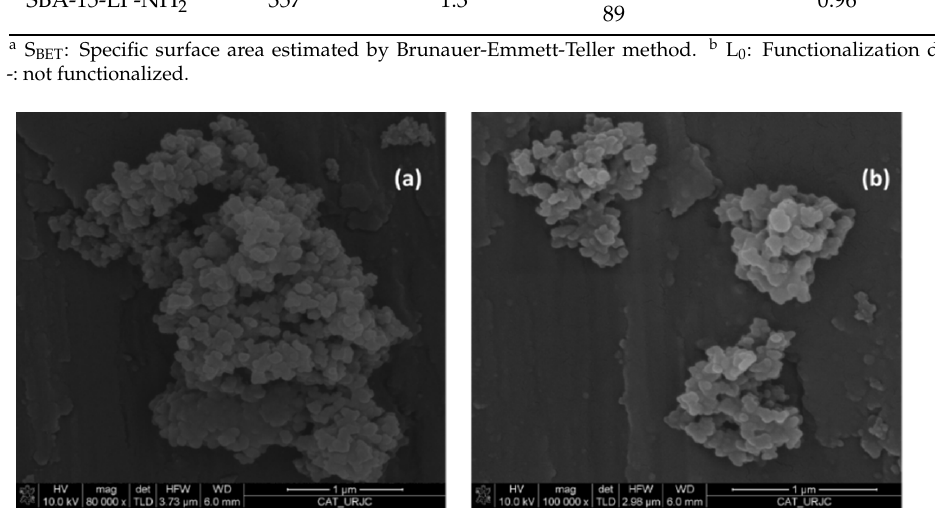
× ( b ) 100,000 × 2 ( a ) 80,000